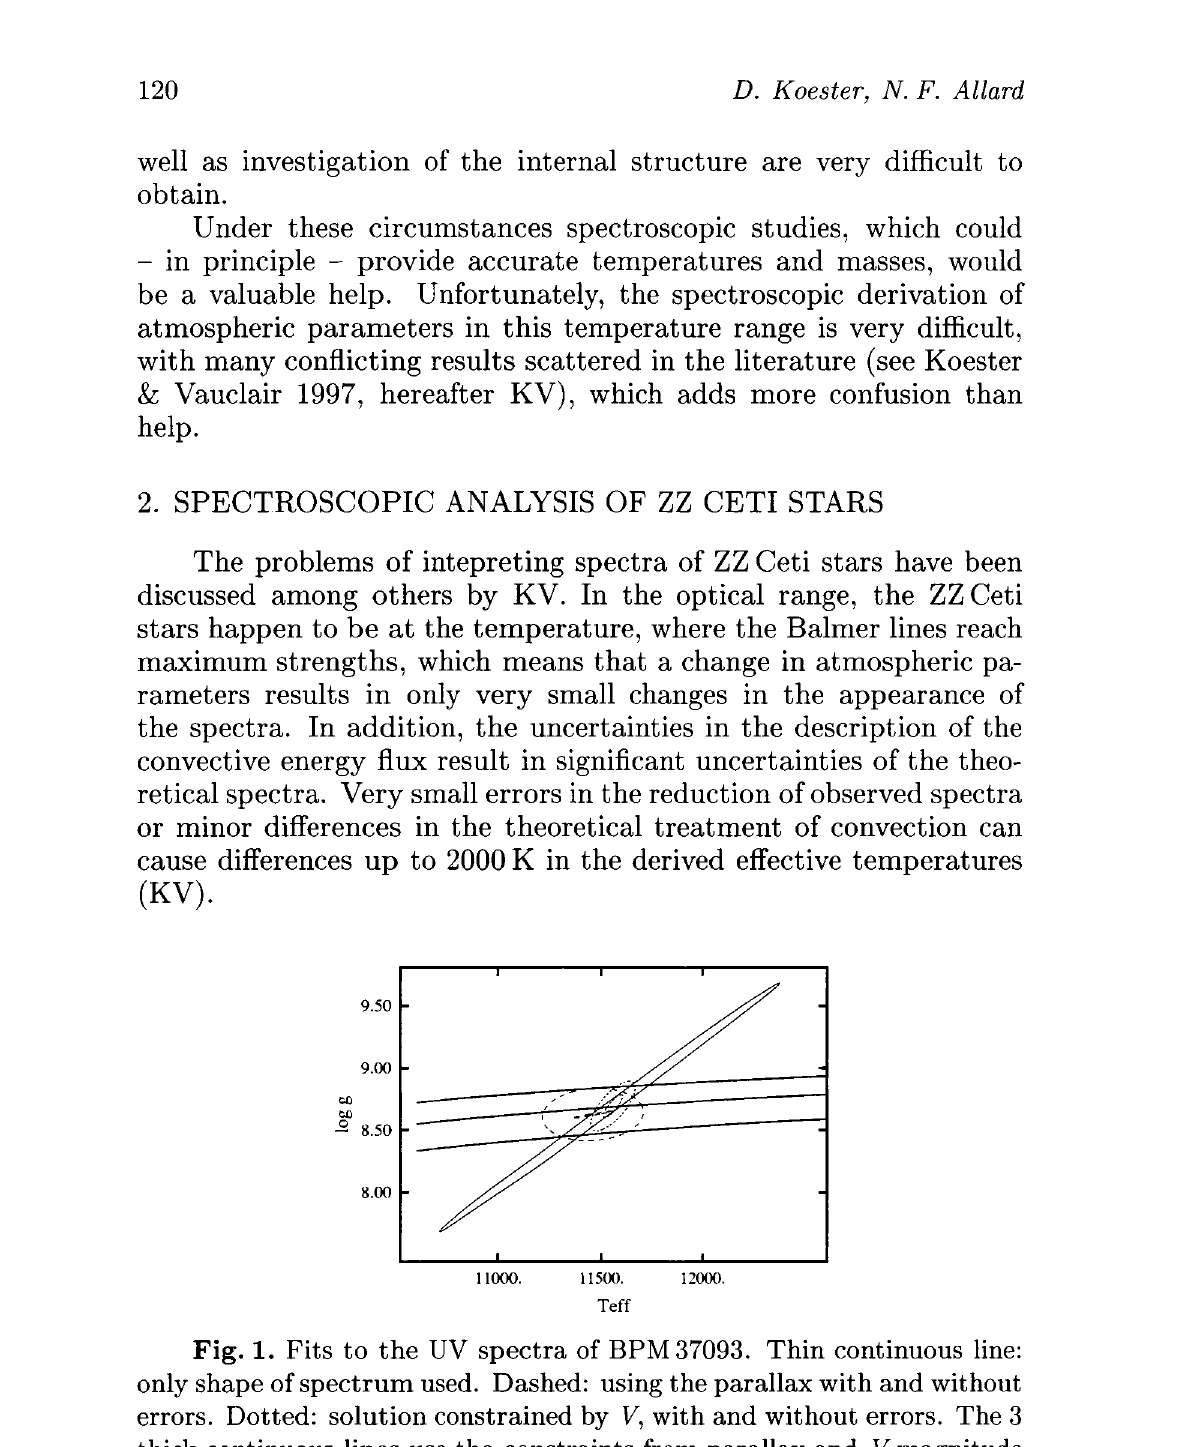
Fig. 1. Fits to the UV spectra of BPM 37093. Thin continuous line: only shape of spectrum used. Dashed: using the parallax with and without errors. Dotted: solution constrained by V, with and without errors. The 3 thick continuous lines use the constraints from parallax and V magnitude only, without any spectral fitting (see